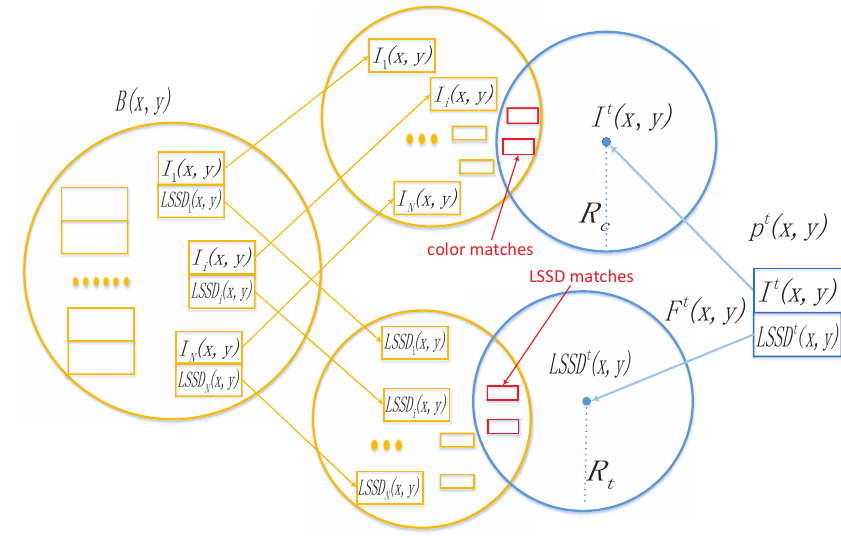
Figure 7. Calculation of the number of matches between the input pixel and its background model.